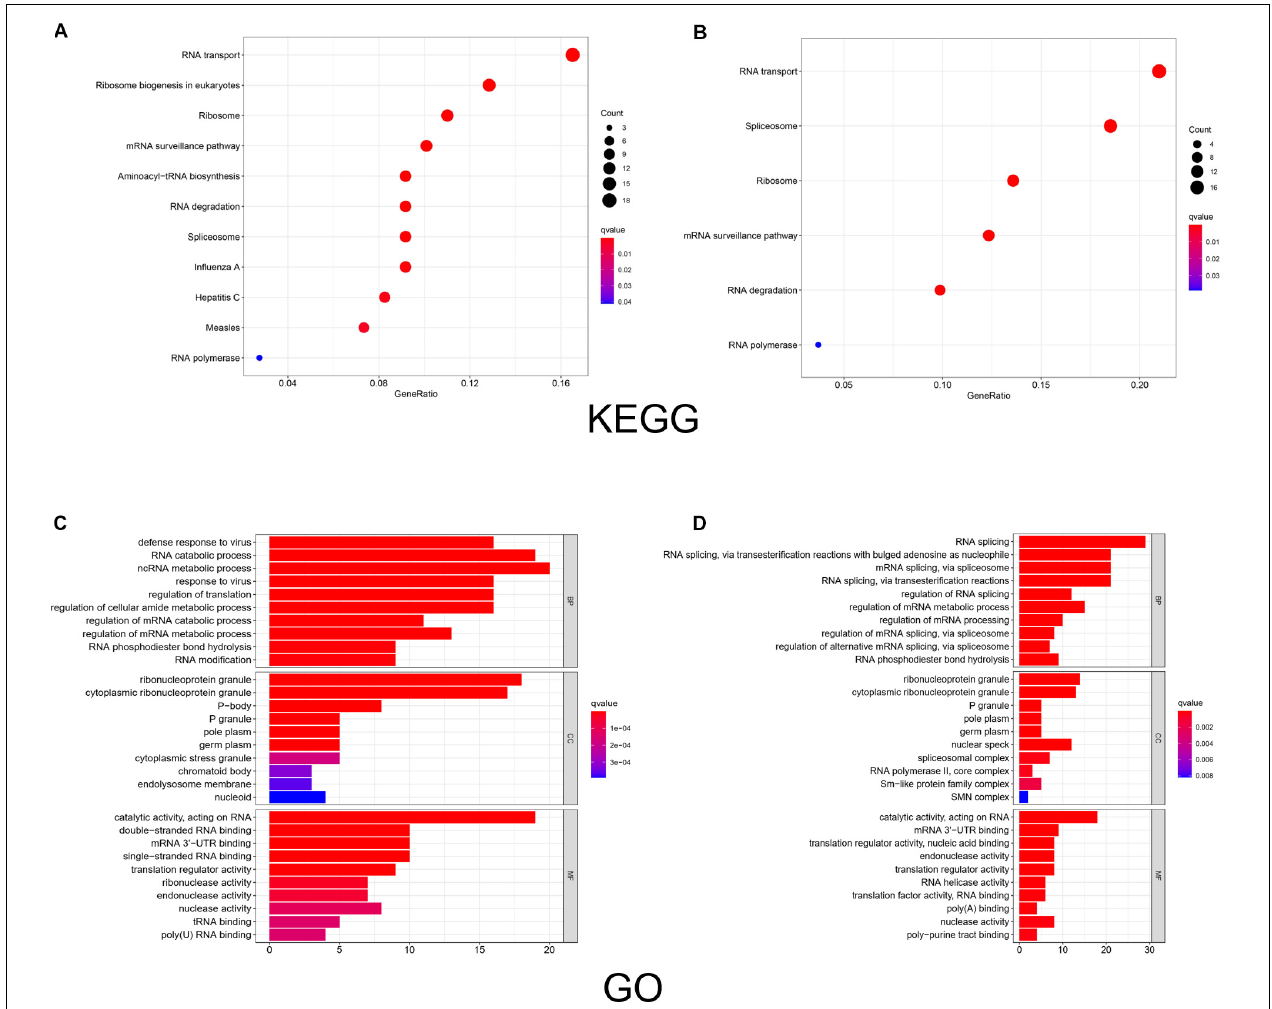
FIGURE 3 | KEGG pathway analysis and GO enrichment analysis of differentially expressed RBPs. The size of a dot in the KEGG analysis represents the relative abundance of the corresponding RBP. The color represents the q value, with a darker red color indicating a smaller q value. And the color bar in the legend of GO analysis represents the q value of the corresponding item. BP, biological process; CC, cellular component; MF, molecular function. (A) KEGG analysis of upregulated RBPs. (B) KEGG analysis of downregulated RBPs. (C) GO enrichment analysis of upregulated RBPs. (D) GO enrichment analysis of downregulated